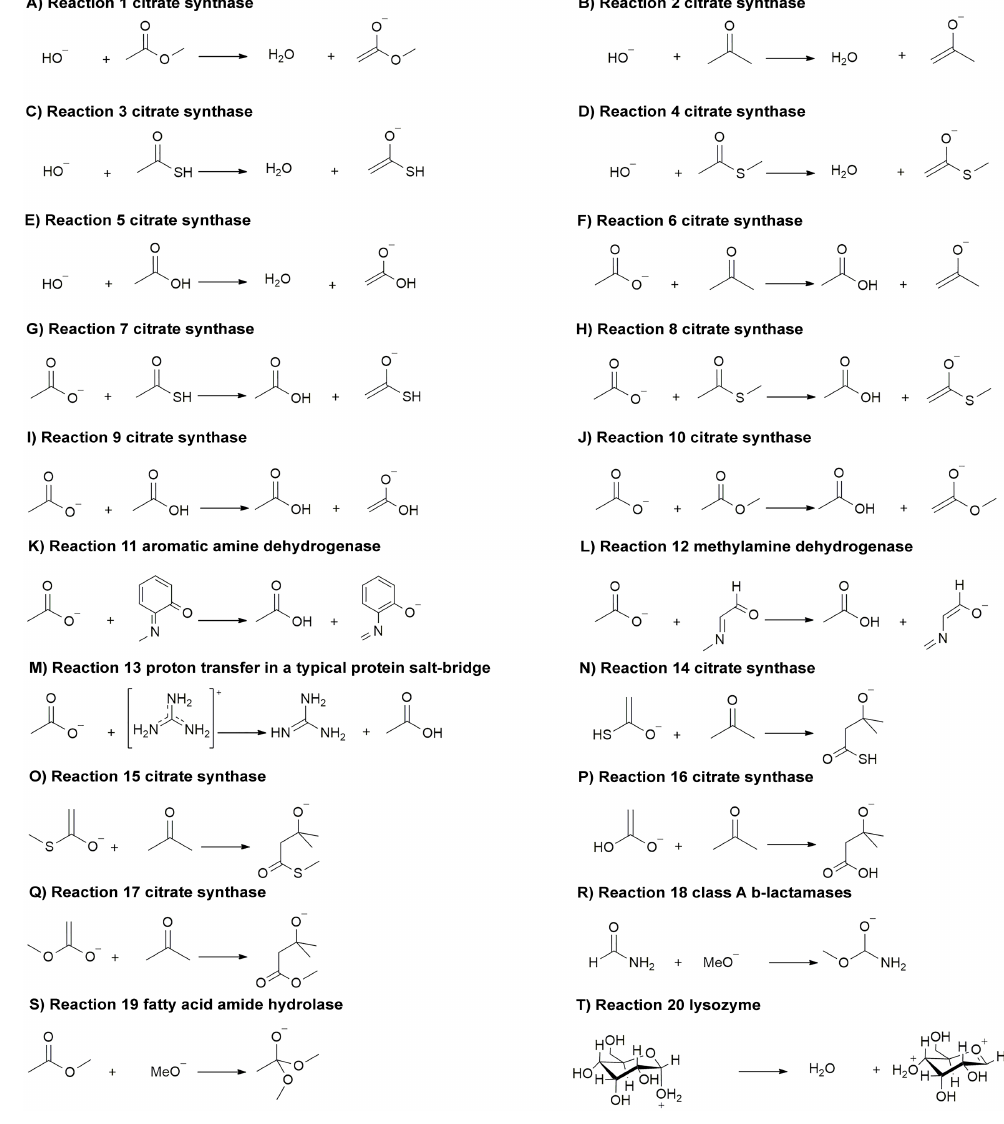
Figure 1 (A-T) Reactions (1–20) related to important classes of enzyme reactions. Full-size DOI: